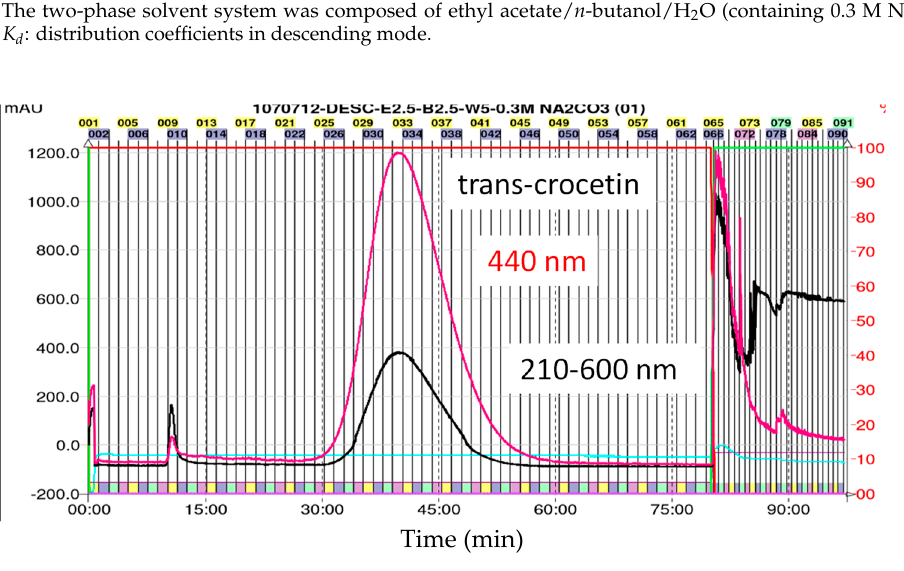
Figure 6. Centrifugal partition chromatography (CPC) obtained from the two ‐ phase solvent system ethyl acetate/ n ‐ Butanol/0.3 M Na 2 CO 3 in water (2.5:2.5:5). Red line indicated the absortion wave ‐ length at 440 nm for the detection of trans ‐ crocetin. Tubes from No. 26 to No. 50 (time 31.25–60 min) were combined and evaporized in vacuo to obtain the target trans ‐ crocetin.